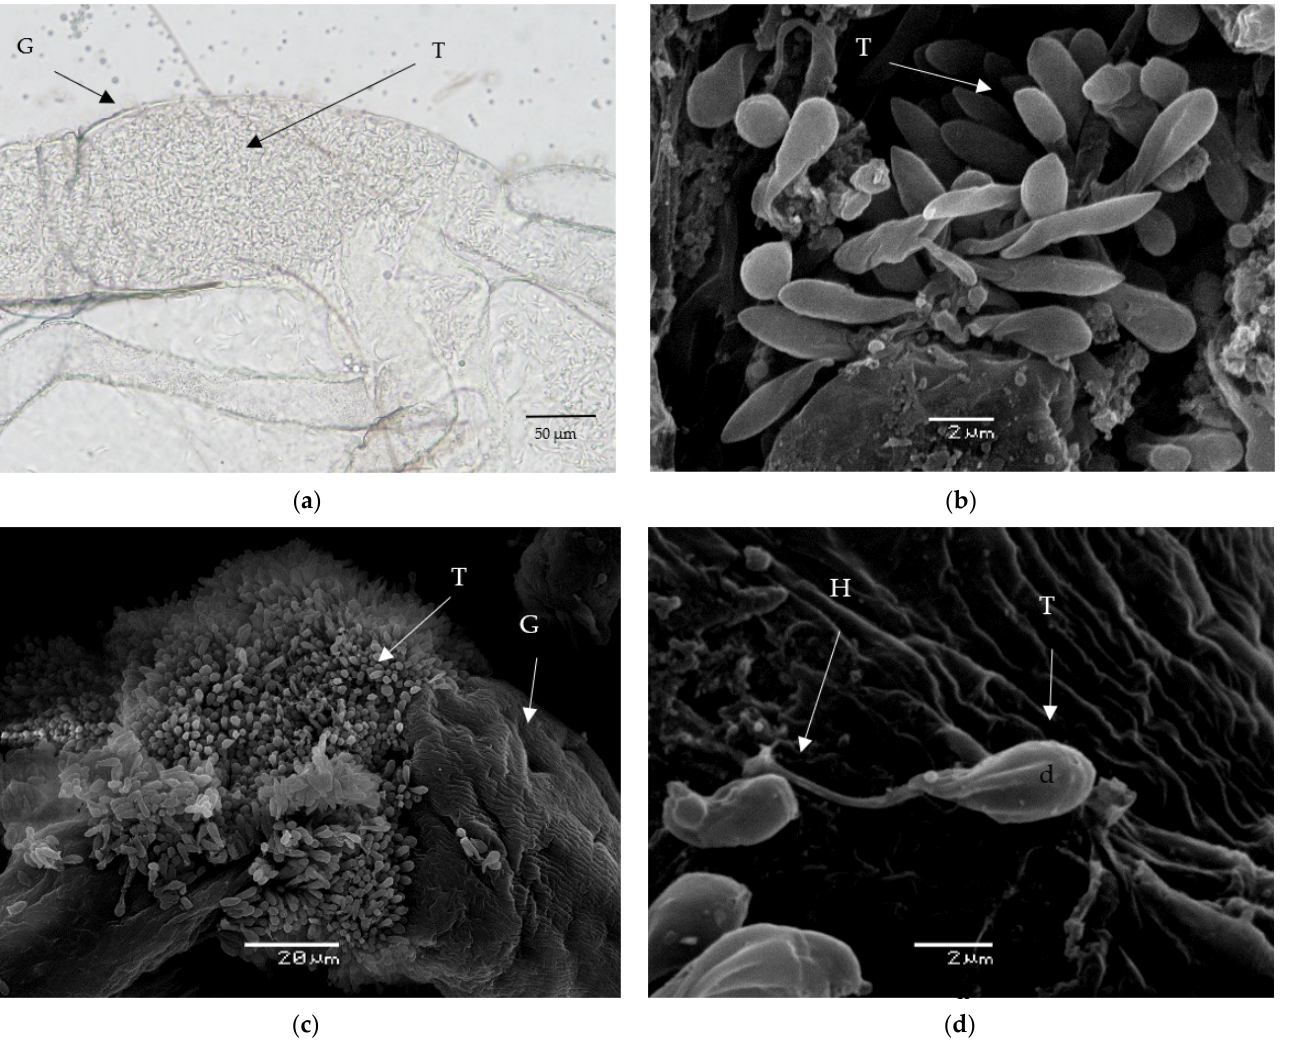
Figure 4. Light and electron microscopy. T. theileri in experimentally infected Ph. perniciosus ( a , b ) and Ae. aegypti ( c , d ). G–gut, T–trypanosomes in the disrupted gut,